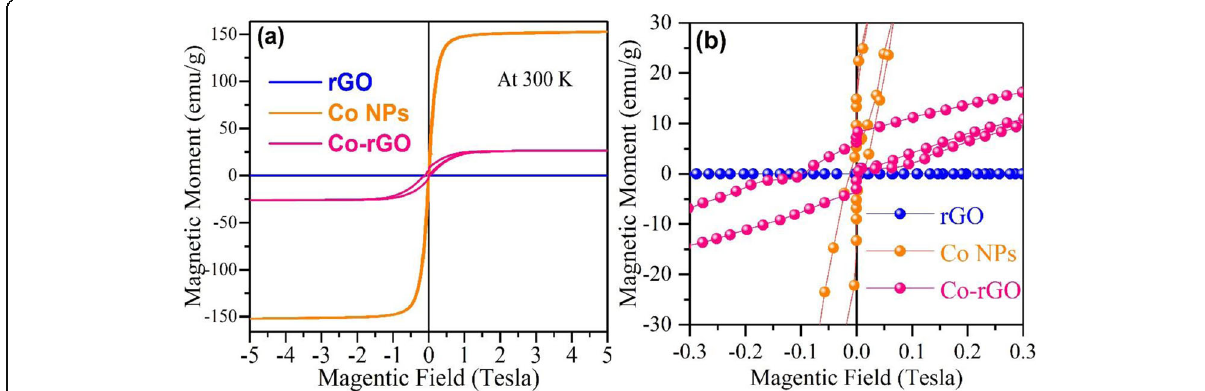
Fig. 5 a Room temperature M-H graph of rGO, Co NPs, and Co-rGO nanohybrid. b M-H graph in the lower field region ( − 0.3 T to + 0.3